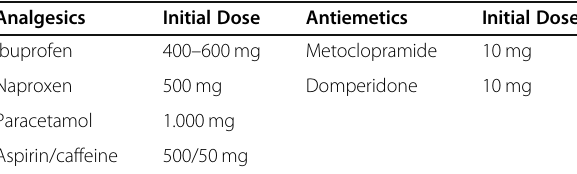
Table 6 Acute treatment of the migraine attack, first step: Simple analgesics and antiemetics with proven effects on the migraine attack and suggested initial doses [10]. These drugs can be used 2 – 3 times a day. Intake of combined analgesics should be limited to max. 9 days per month to avoid medication overuse headache. Tolfenamic acid 200 mg and diclofenac 50 – 100 mg can also be